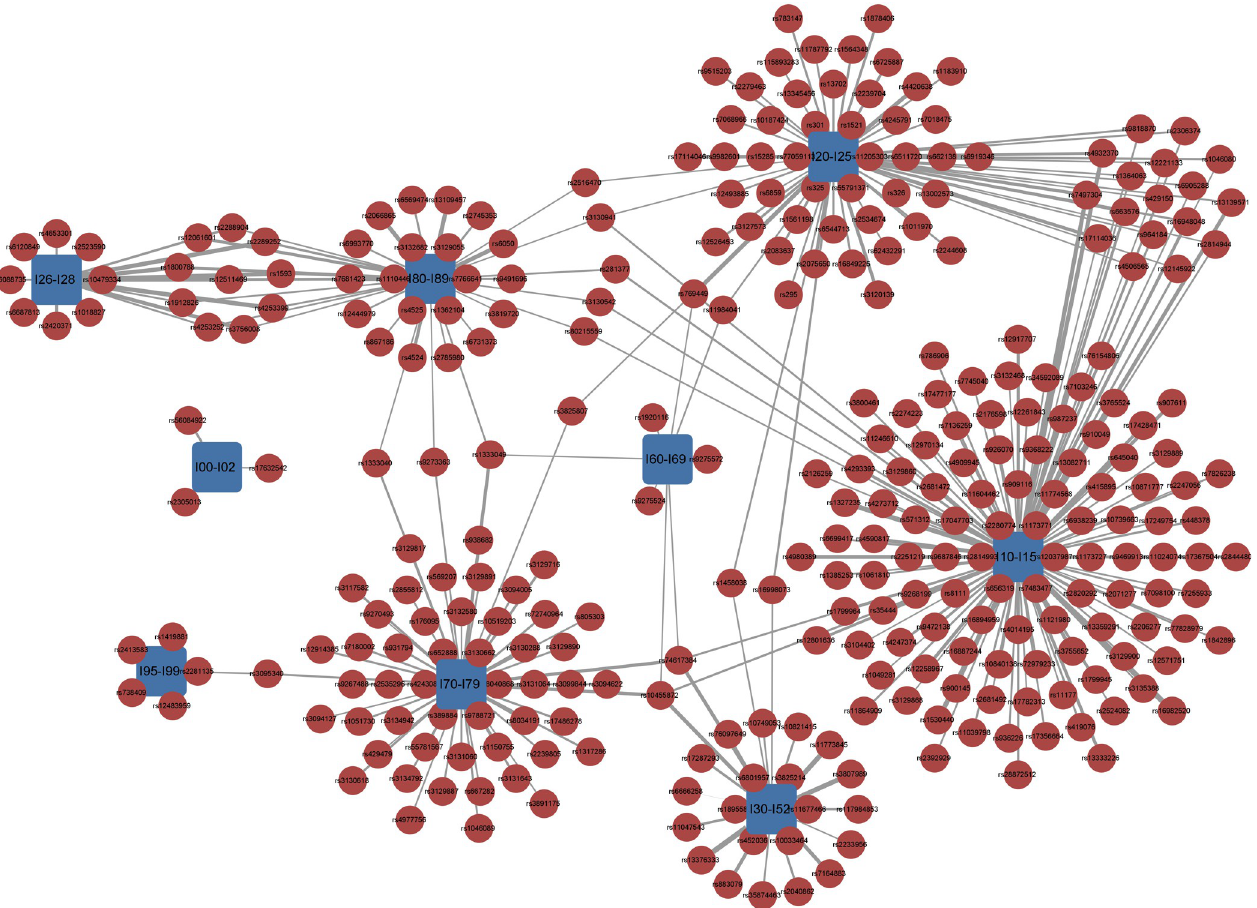
Fig 3. The associations between SNPs and the circulatory system phenotypic blocks identified by the HCLC-FC method. The red circles represent SNPs, and the blue squares represent nine diseases of the circulatory system phenotypic blocks I00-I99 (I00-I02: Acute rheumatic fever; I10-I15: Hypertensive diseases; I20-I25: Ischaemic heart diseases; I26-I28: Pulmonary heart disease and diseases of pulmonary circulation; I30-I52: Other forms of heart disease; I60-I69: Cerebrovascular diseases; I70-I79: Diseases of arteries, arterioles and capillaries; I80-I89: Diseases of veins, lymphatic vessels and lymph nodes, not elsewhere classified; I95-I99: Other and unspecified disorders of the circulatory system). The width of the connection line represents the strength of association (-log10 scale p-value).